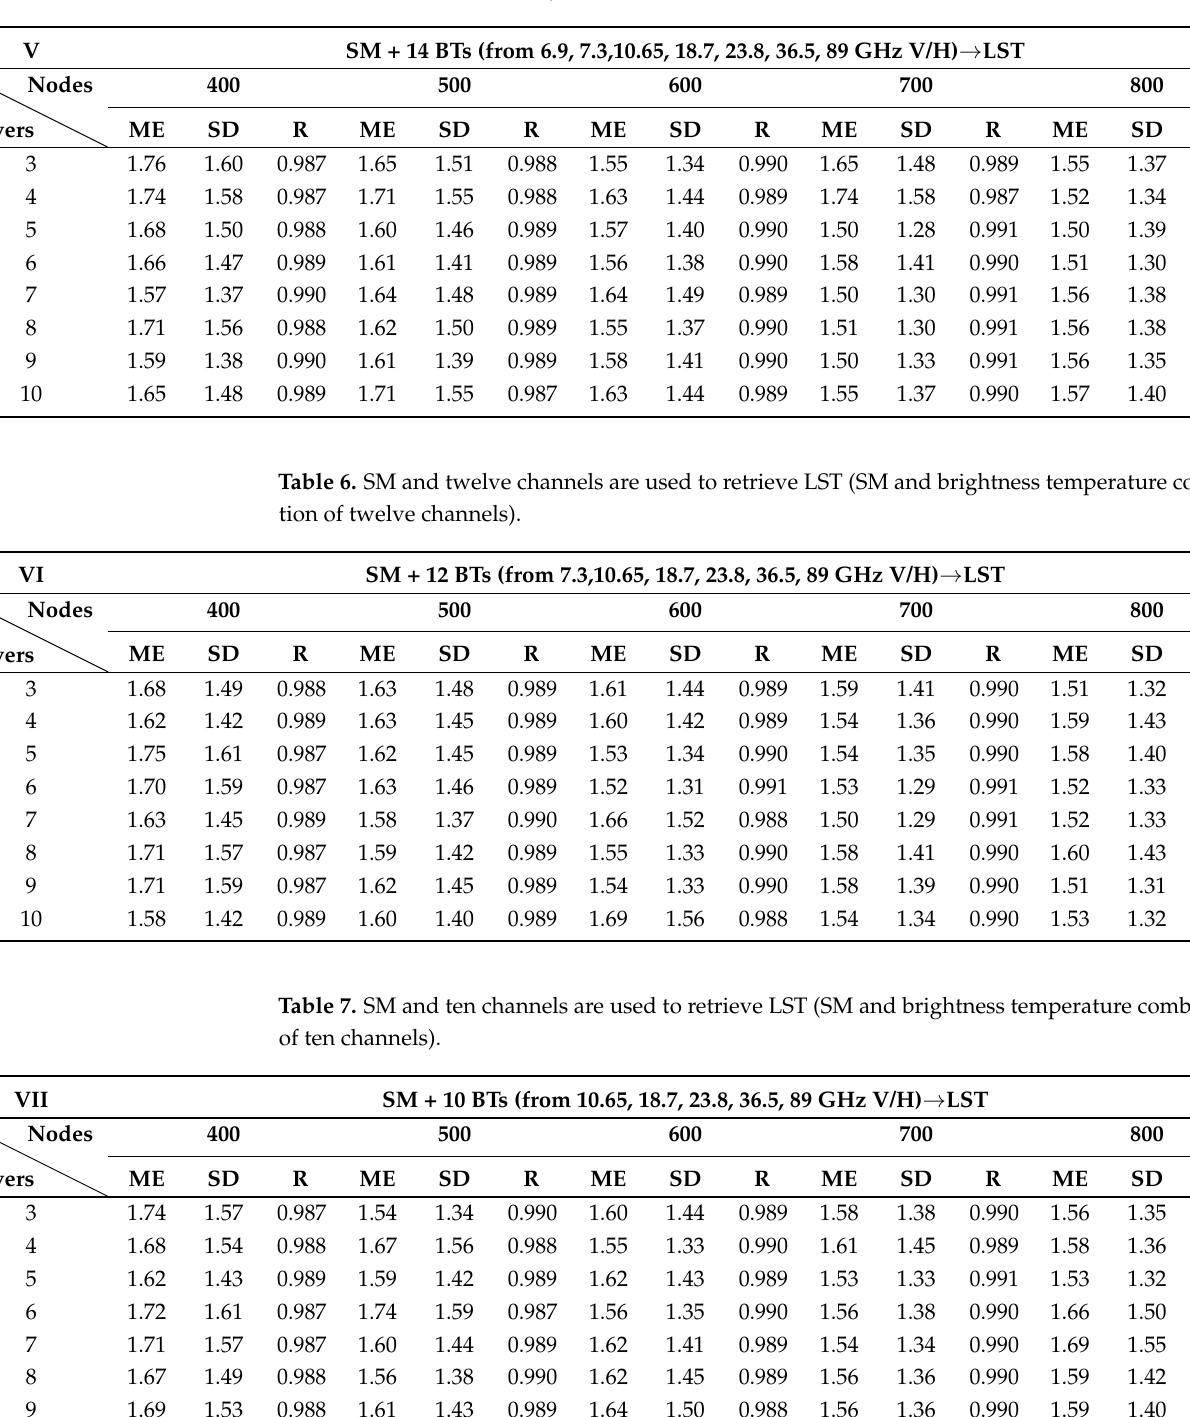
Table 5. SM and fourteen channels are used to retrieve LST (SM and brightness temperature combi- nation of fourteen channels).